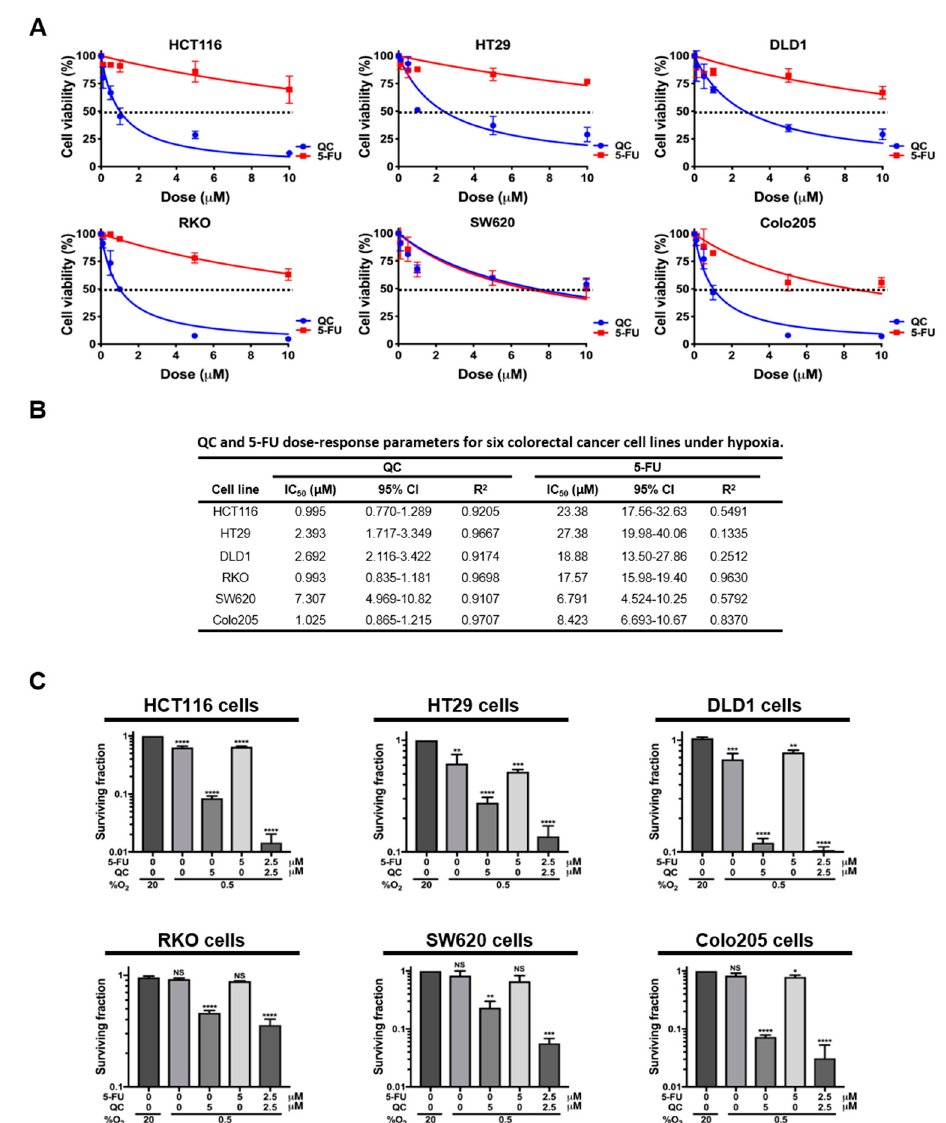
Figure 1. Quinacrine (QC) sensitizes colorectal cancer (CRC) cells to 5-fluorouracil (5-FU) treatment under hypoxic conditions. ( A ) ATP-Glo assay of the QC or 5-FU treatments in HCT116, HT29, DLD1, RKO, SW620, and Colo205 cells. ( B ) Summary of IC 50 values and associated 95% confidence intervals (CI) for QC, 5-FU, and combined QC and 5-FU treatment in all tested CRC cell lines. ( C ) Clonogenic survival assay for the QC / 5-FU combination and single-agent treatments in HCT116, HT29, DLD1, RKO, SW620, and Colo205 cells. Data are presented as means ± SD (* p < 0.05, ** p < 0.01, *** p < 0.001, **** p < 0.0001 by ANOVA). “NS” indicates not significant ( p > 0.05).